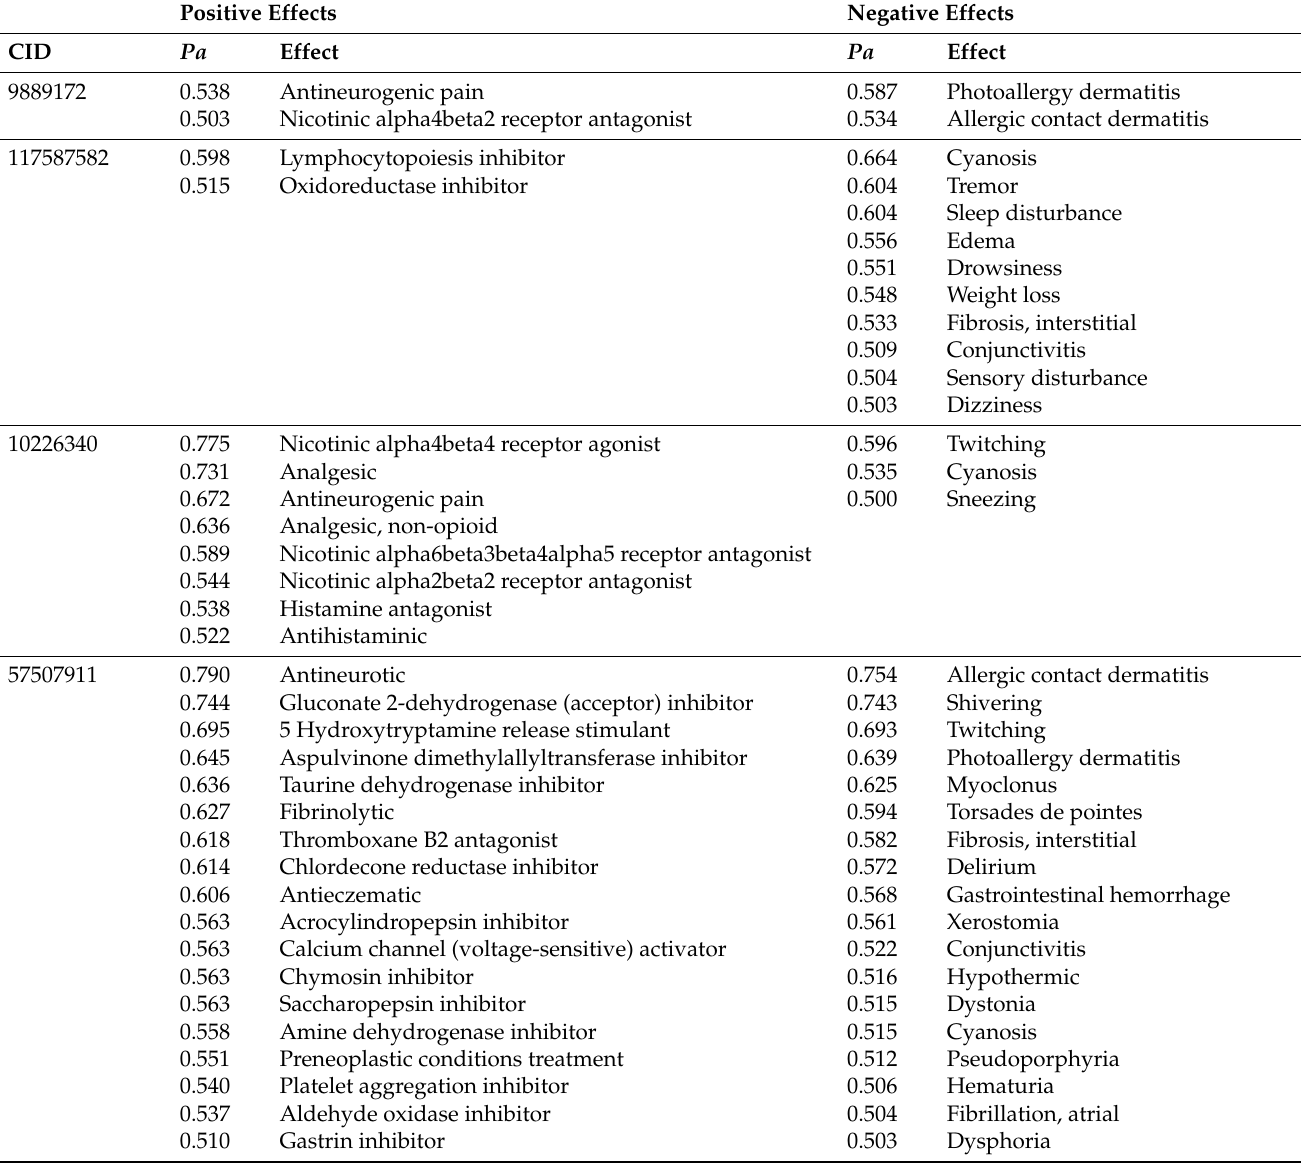
Table 7. Positive and negative effects of the Benzoylindoles that appear with probabilities greater than